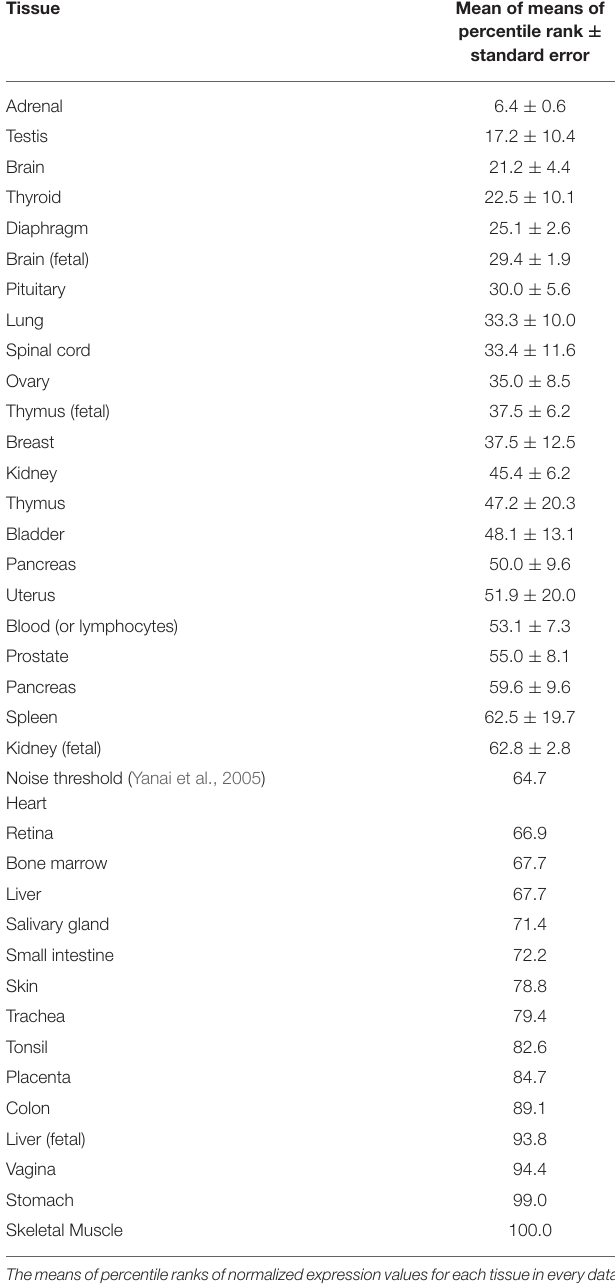
TABLE 1 | Relative rank order of tissue expression of lipocalin-interacting membrane receptor from multiple GEO data sets. Tissue